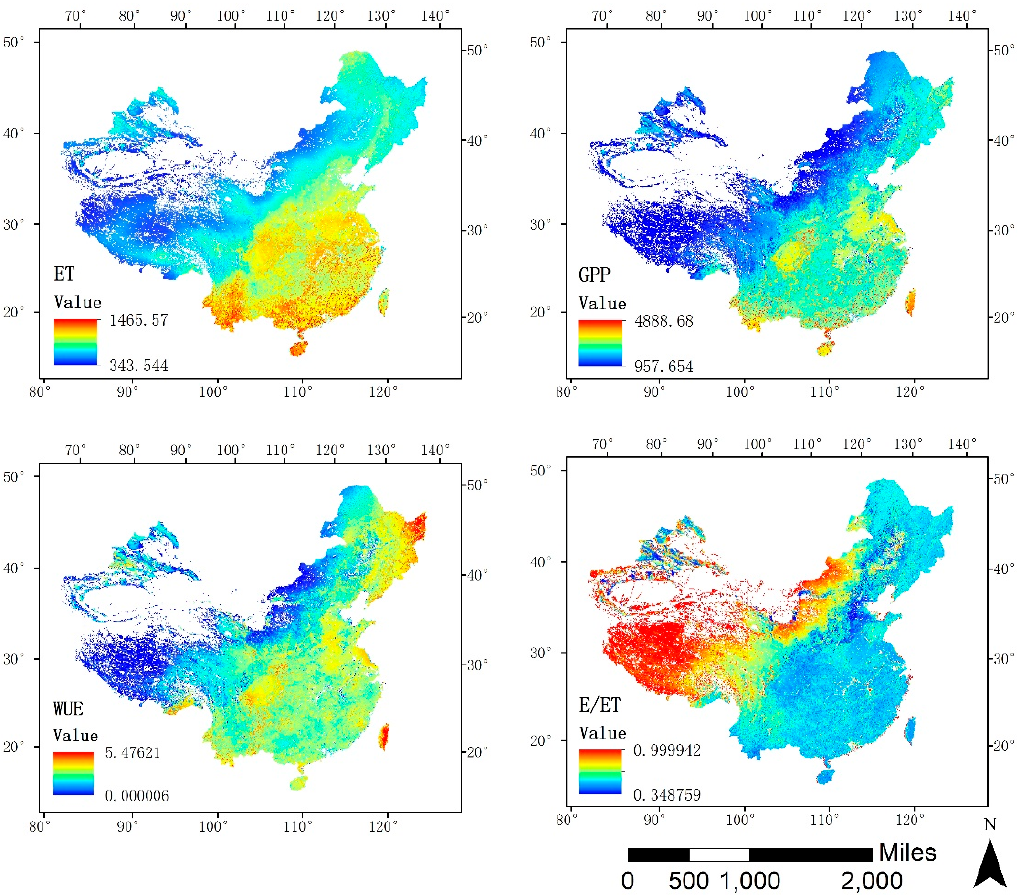
Figure 5. Spatial patterns of ET, GPP, water-use efficiency (WUE: GPP/ET) and the ratio of soil water evaporation to ET (E/ET) in China from 2001 to 2010.